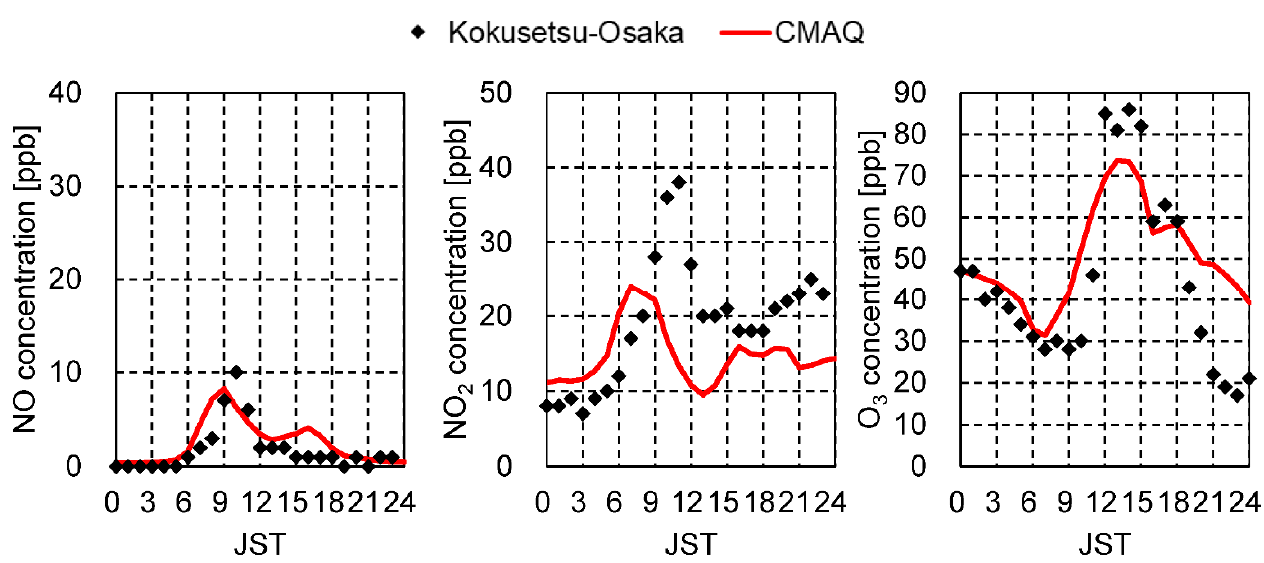
Figure 6. Time series of pollutants concentration outside the canyon. Kokusetsu-Osaka is the observation station locating 4 km east-southeast of analysis domain. CMAQ is the calculation results of CMAQ (described in Section 3.2).